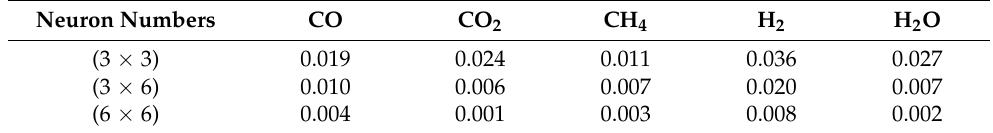
Table 1. Standard deviations of the prediction errors using different ANN models.